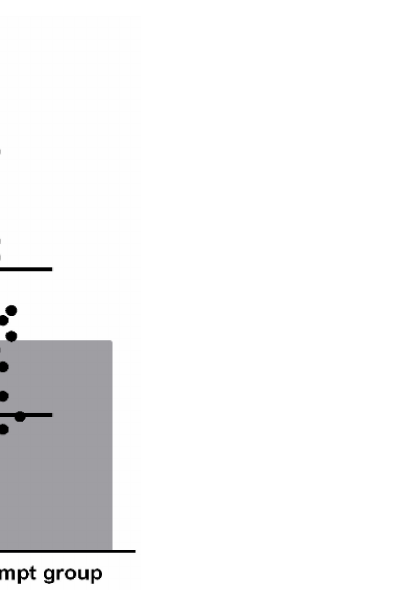
Figure 1. IL-6 levels in suicide attempts and comparison groups. * Statistical significance; • Participants.